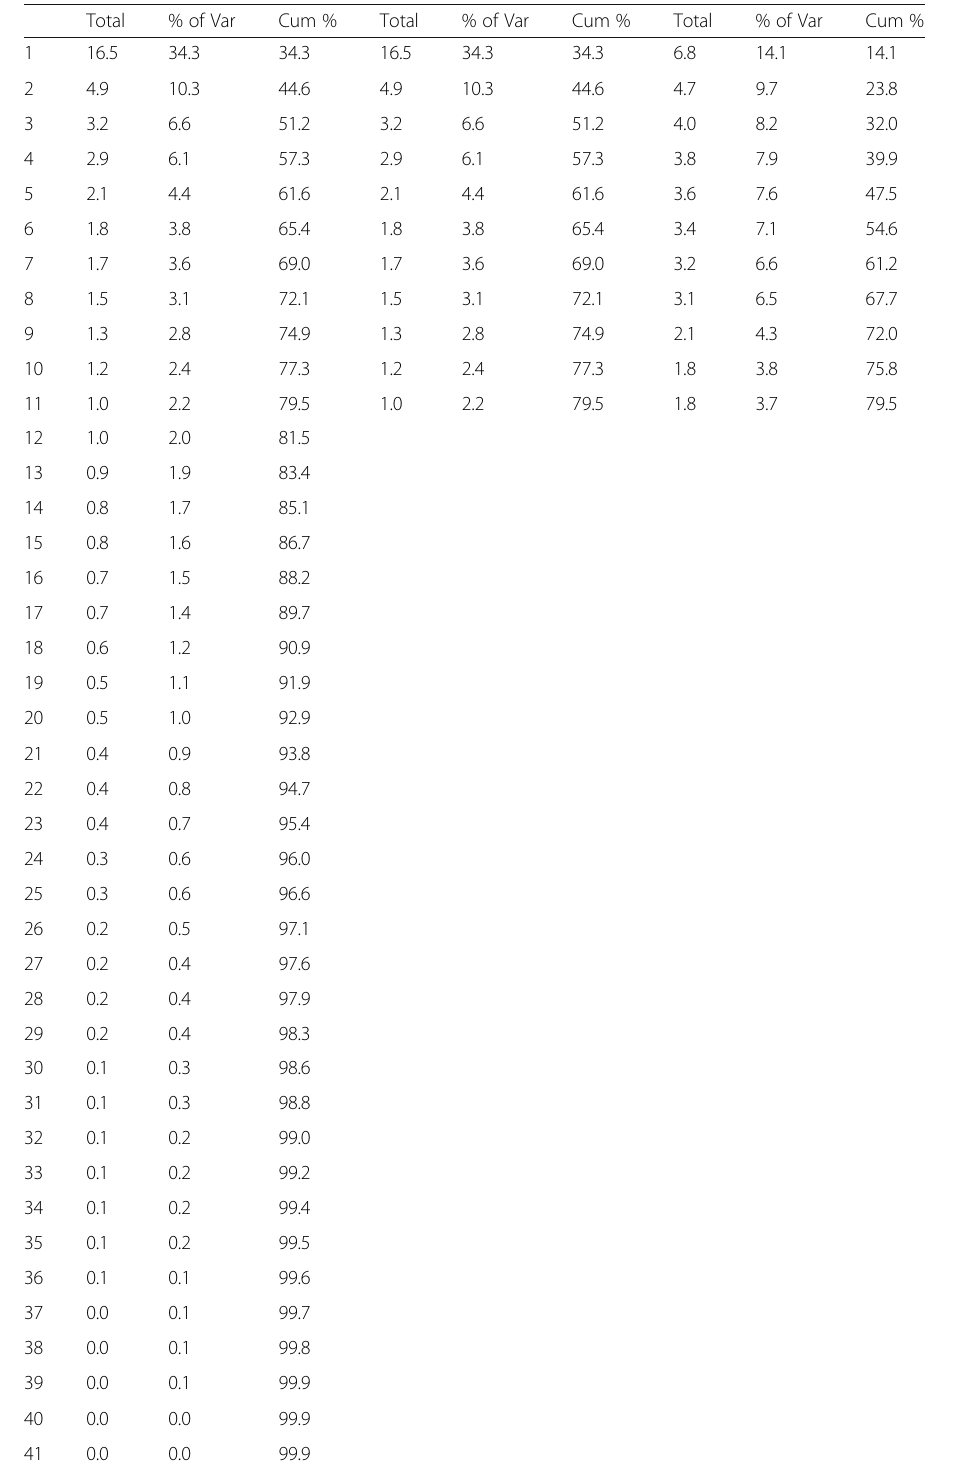
Table 2 Total Variance